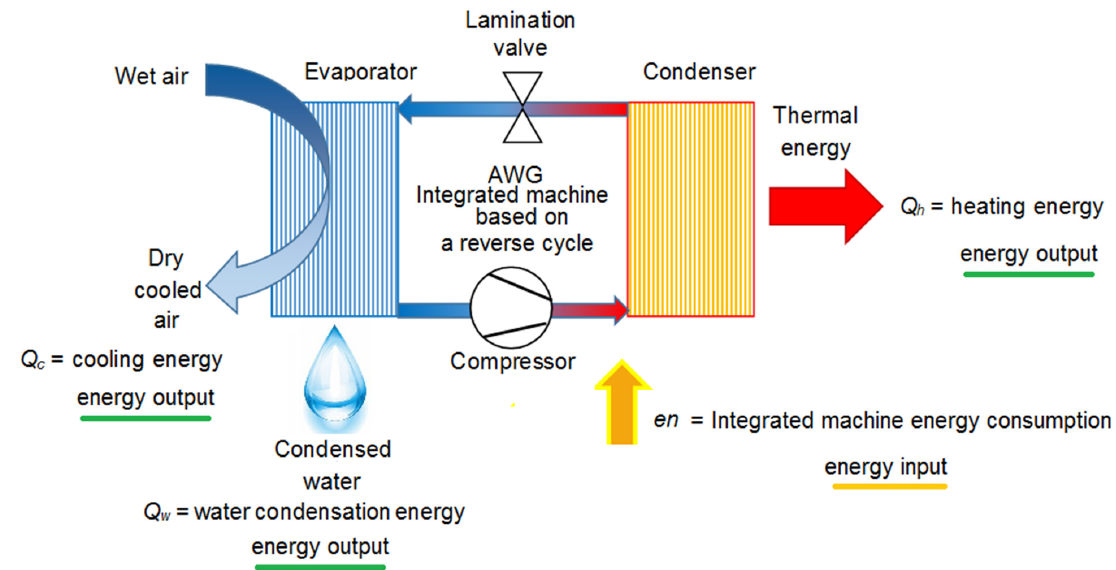
Figure 2. AWG-integrated machine: energy input and outputs. Figure 2. AWG ‐ integrated machine: energy input and outputs.